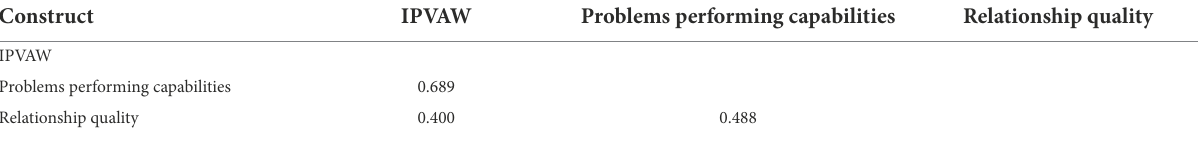
TABLE 2 Heterotrait-Monotrait ratio—HTMT for discriminant